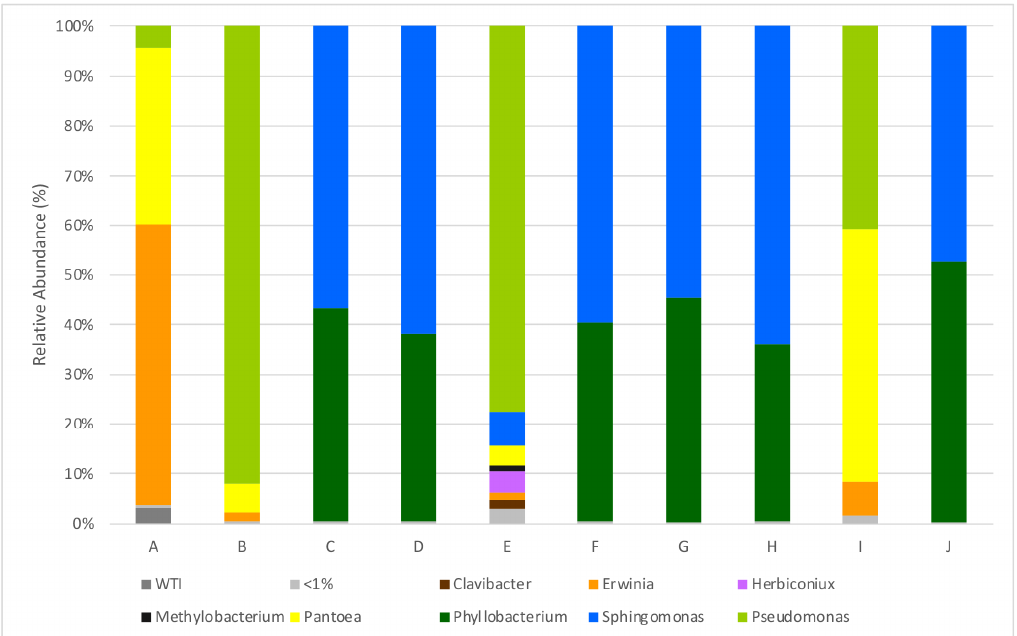
Figure 1. Relative abundances (%) of dominant sequences (>1%) assigned to genus level that were identified in samples based on partial sequence analysis of the V3–V4 regions of the 16S rRNA gene. WTI refers to the percentage of sequences without taxonomic attribution to the specified taxonomic level. A–J refers to the origin of the sequenced sample, as described in Table 1.